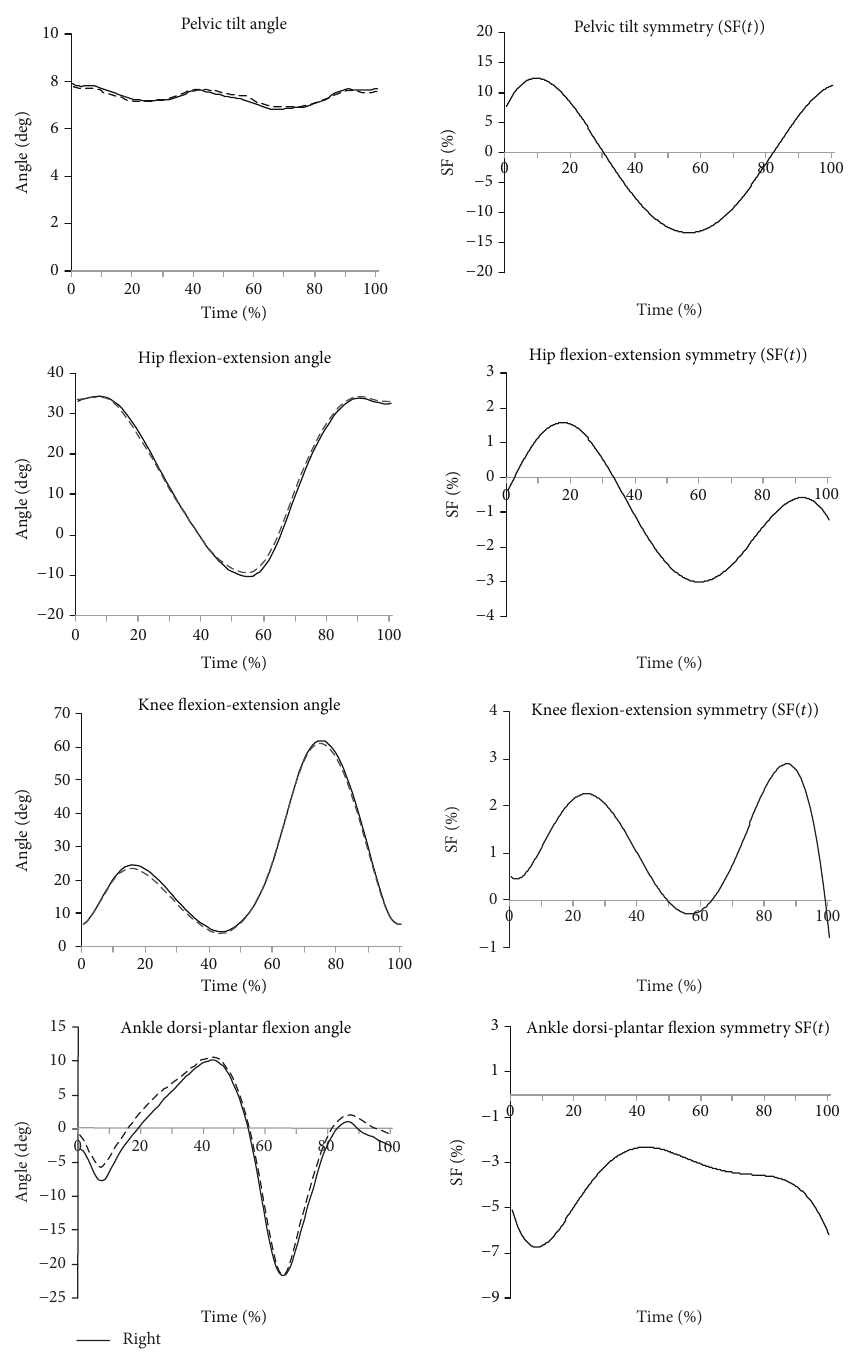
Figure 2: Angular joint kinematics in the sagittal plane and corresponding symmetry function (SF) for the normal group. Positive values of SF indicate right-side dominance in asymmetry, while negative values show left-side